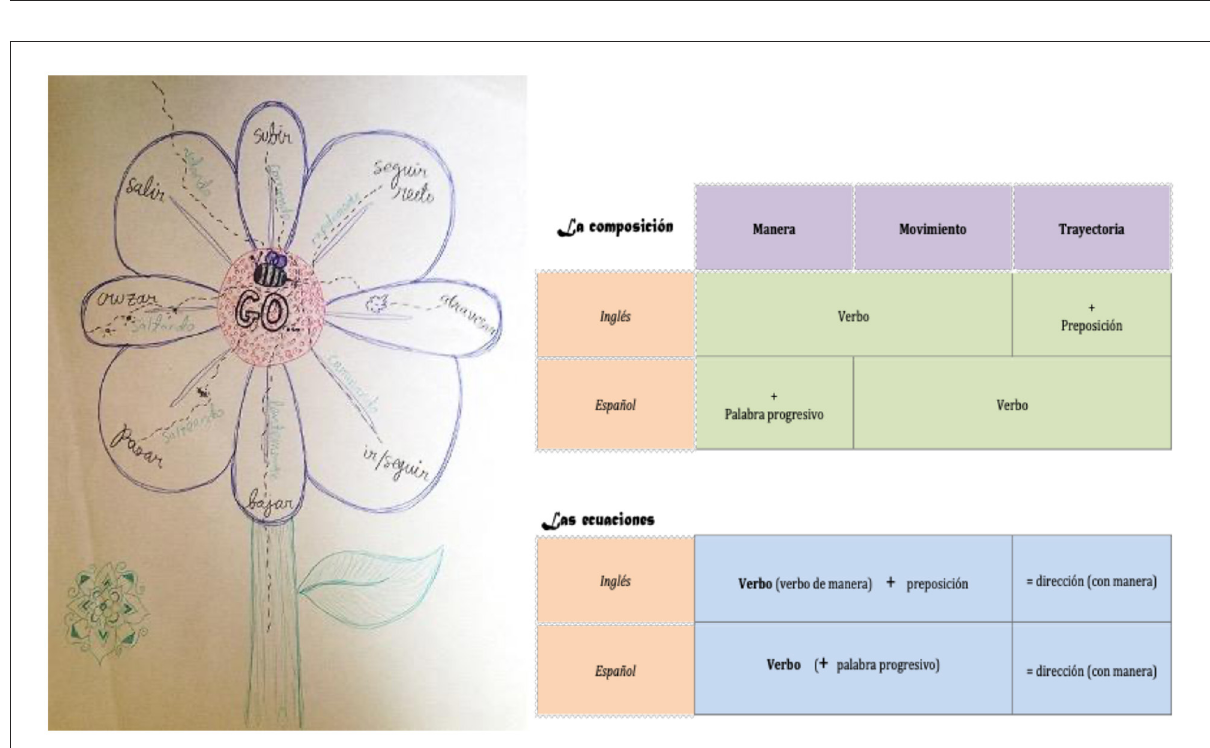
FIGURE5 Didactic models: “Flower” + schema diagram (Participant 4, Group